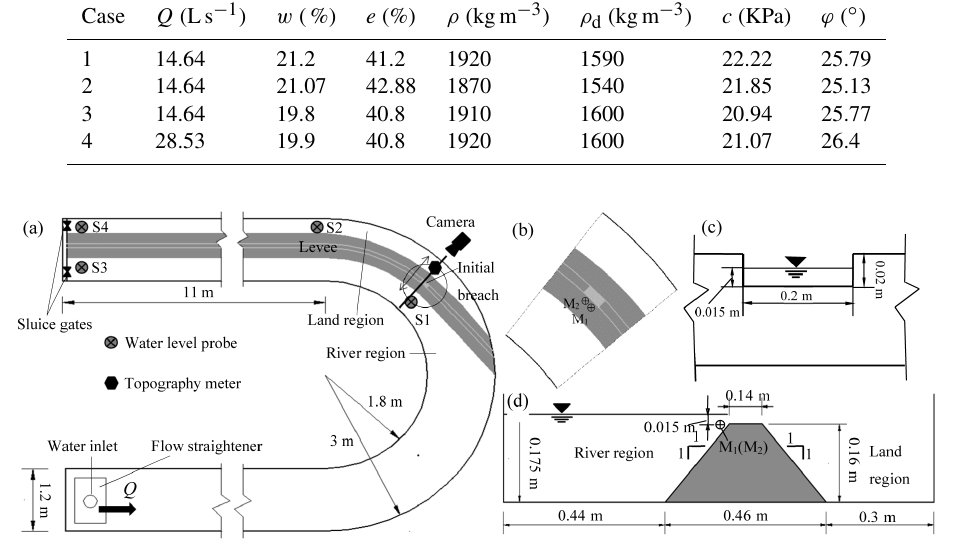
Figure 1. Levee model: (a) top view of experiment layout, (b) velocity monitoring point, (c) longitudinal section of initial breach and (d) transverse section of initial